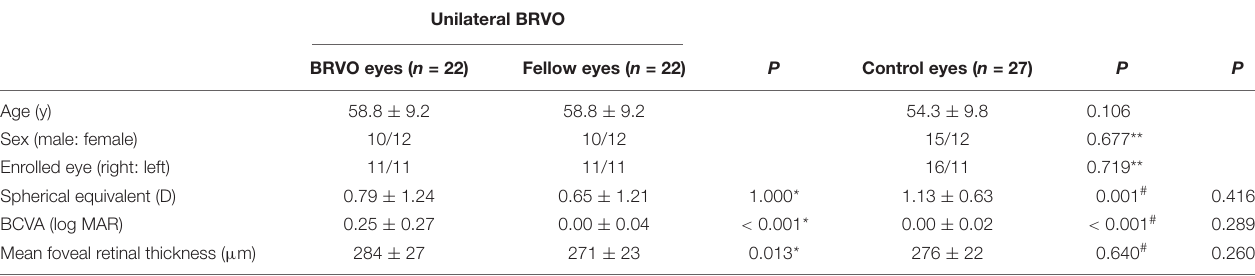
TABLE 1 | Patient demographic and characteristic.